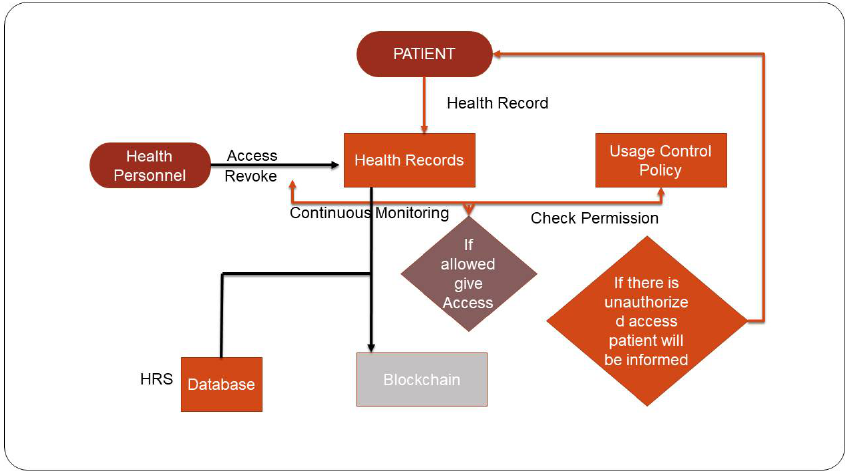
Figure 2. The research methodology explaining our proposal for a user-centric health record